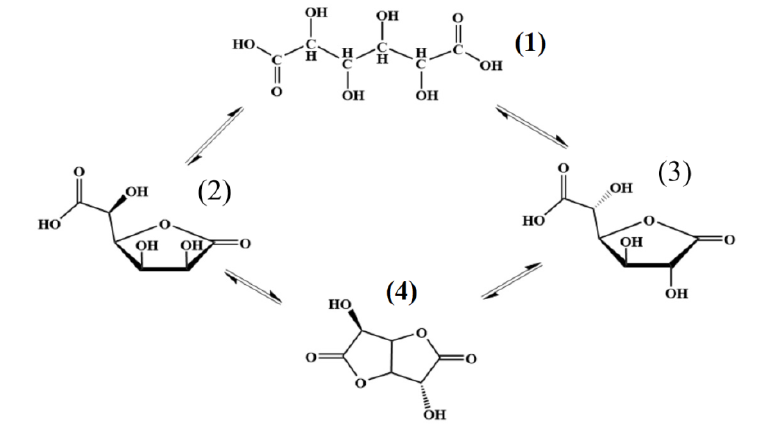
Figure 3. Comparison of activities of 1,4-glucarolactone and the polymer complex against β - glucuronidase present in rat urine: 1-1,4-GL; 2–racemic mixture of 1,4- and 6,3-GL.